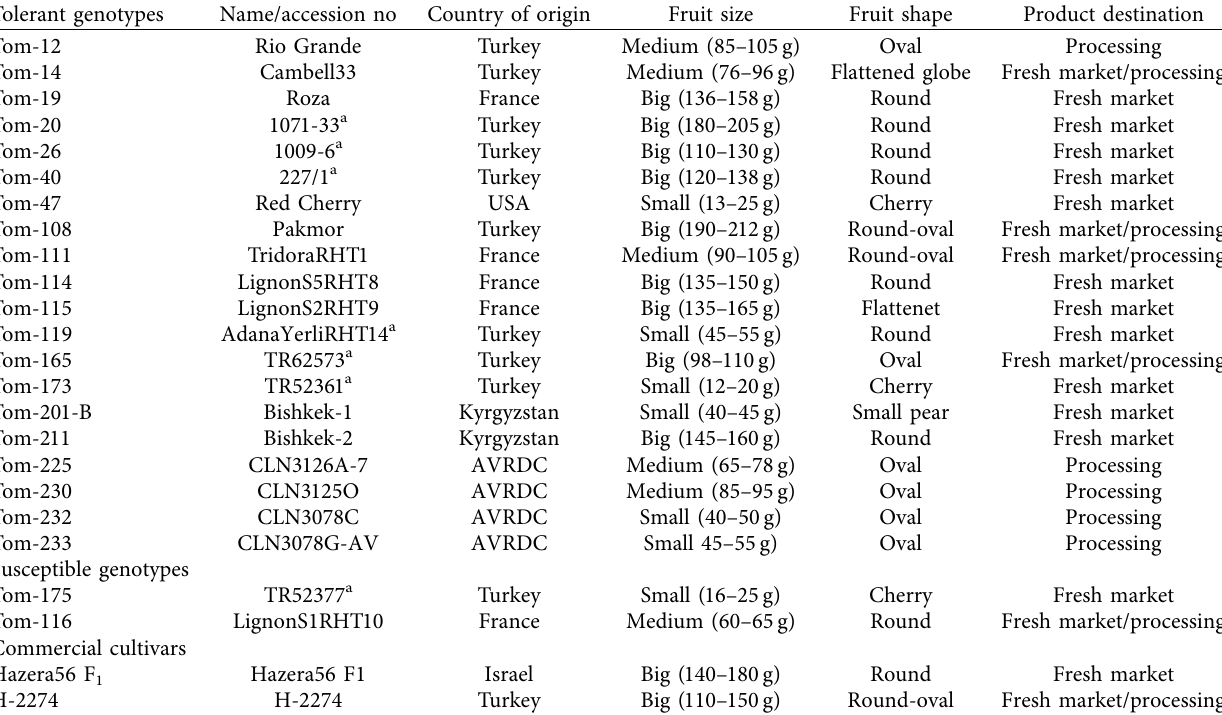
Table 2: Genotypes of tomato used in studies: high-temperature tolerant and susceptible genotypes and commercial tomato varieties ∗ . Tolerant genotypes